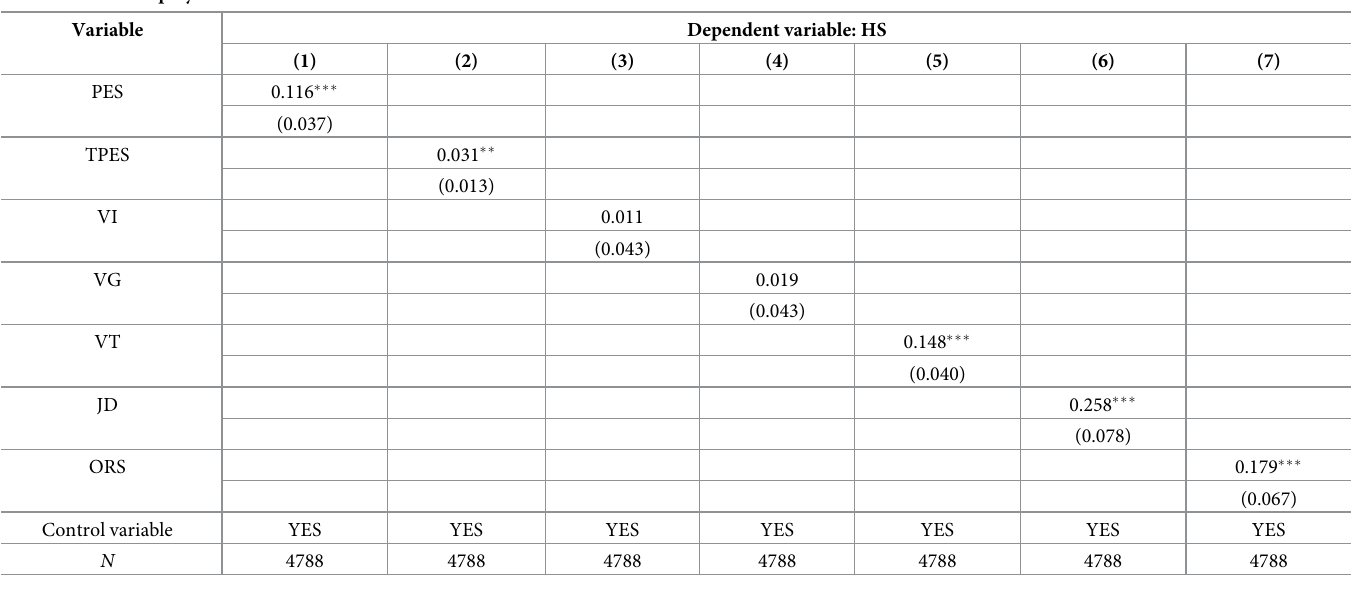
Table 2. Public employment services and self-rated